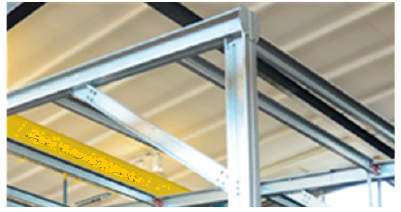
Figure 3. Knee brace joint at eaves.